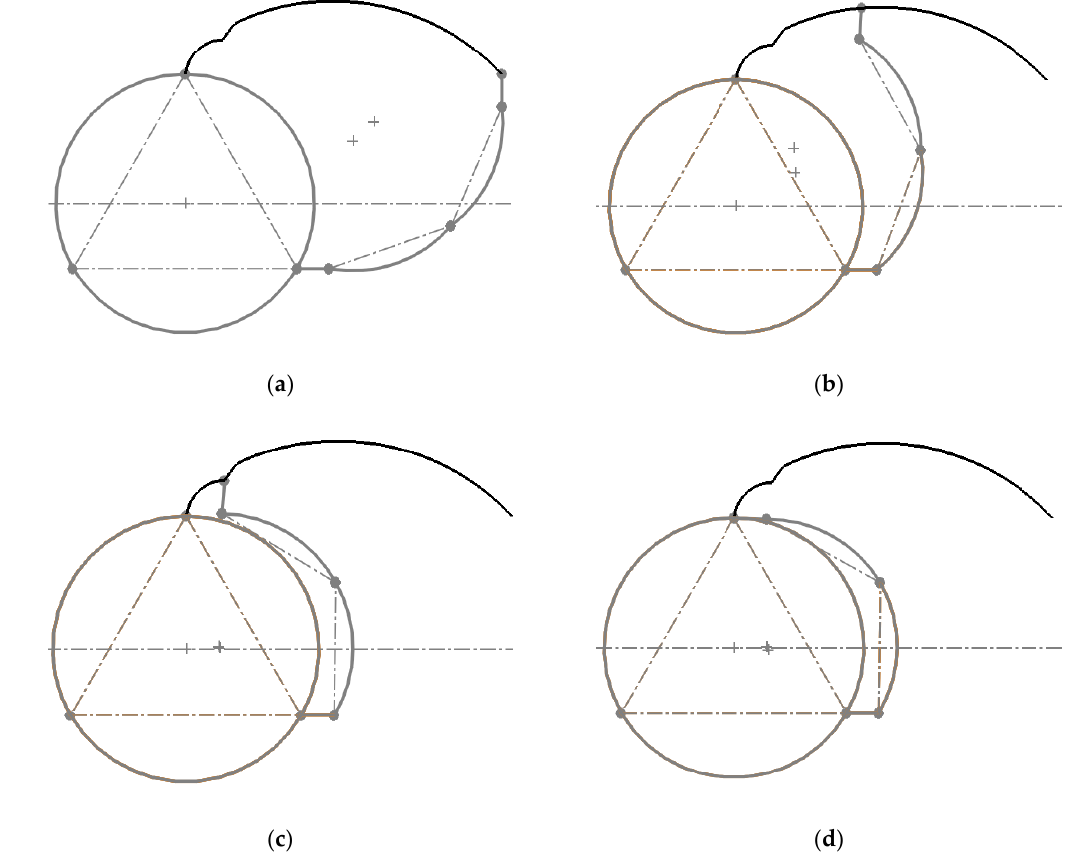
Figure 4. Kinematic simulation phases: ( a ) starting position, ( b ) middle position, ( c ) approaching position, ( d ) closed position.